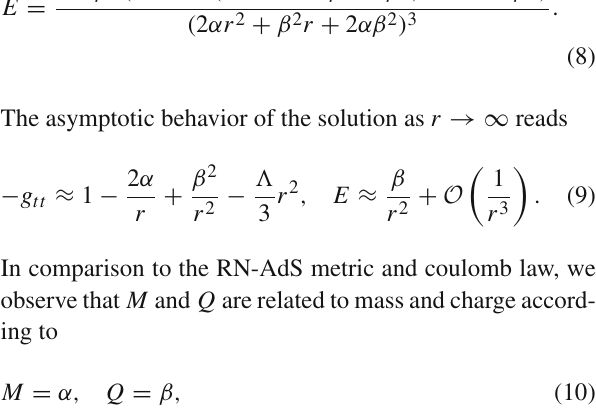
Fig. 1 Thebehaviorof − g tt intermsof r for Q = 0 . 5withnohorizons (long dashed line), Q = 0 . 827 extremal (solid line ) and Q = 1 with two horizons (dashed line) and (cid:2) = − 0 . 01, M = 1 (all three cases)